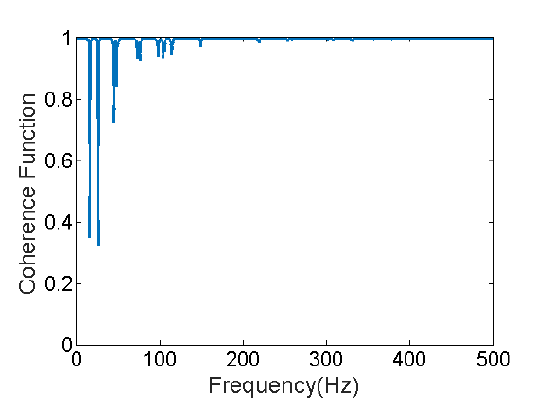
Figure 5. Multiple coherence function is always between zero and one. One indicates all the measured output is due to the considered inputs while zero means other factors (noises, unconsidered input, etc.) have caused the output(s).